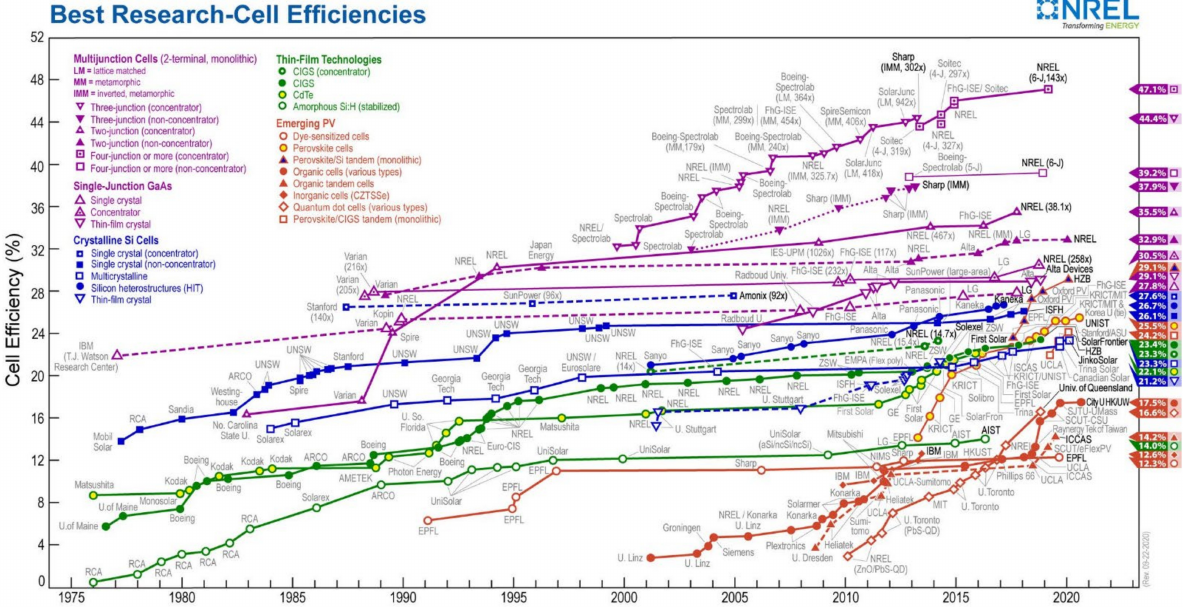
Figure 4. The NREL best research-cell efficiency chart.